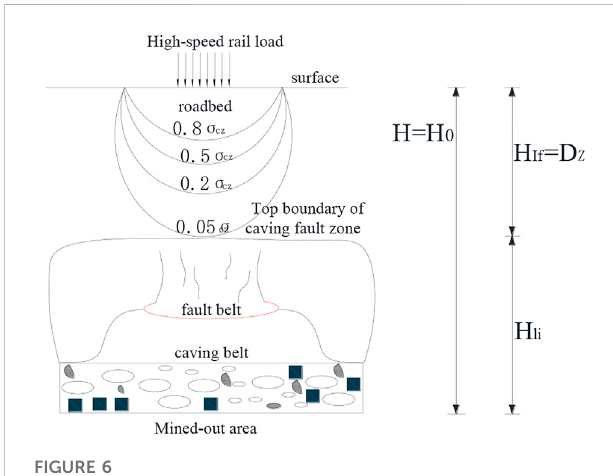
FIGURE 6 Positional relationship: Tangent.